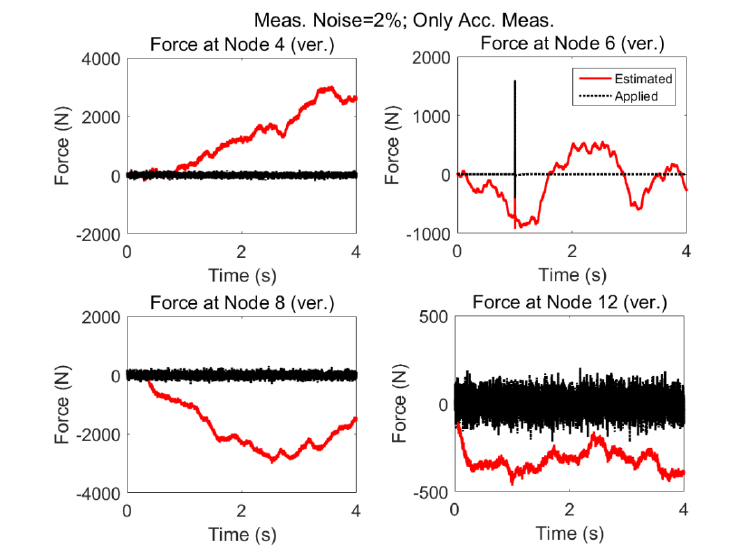
Figure 10. Same loading as in Figure 8, but in this case both the measurement noises (2%) and modelling errors (5%) are